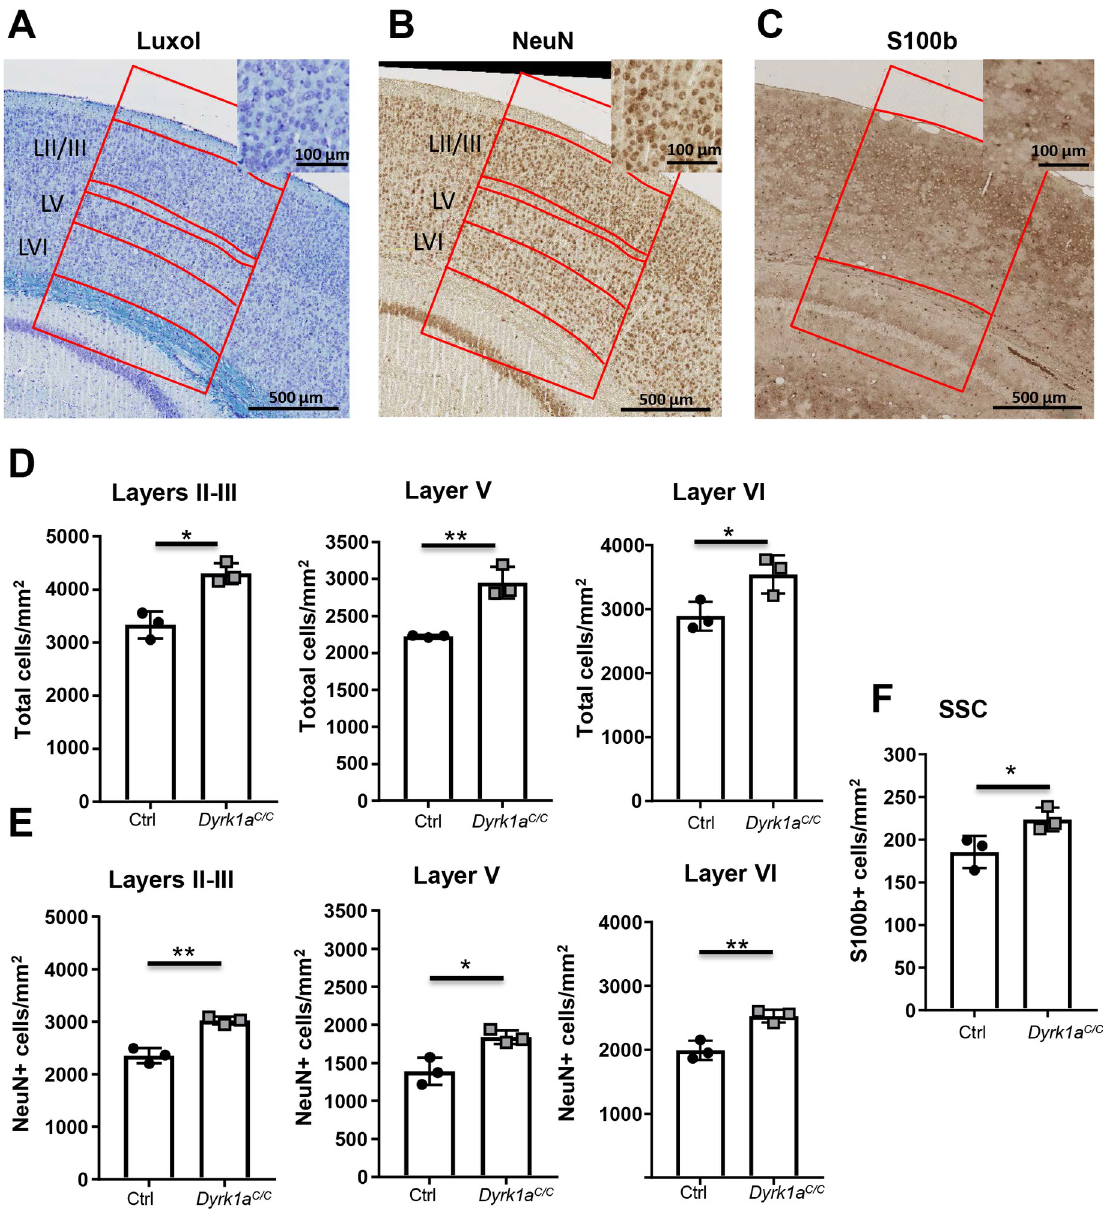
Fig 3. Analysis of cell density in the SSC of Dyrk1a C/C mice. Representative cresyl violet and luxol blue stained (A), NeuN-labeled (B) and S100b-labeled (C) coronal sections at Bregma -1.5 with the counting frames. (D-F) Relative density of cells counted within a frame of 0.1 cm width at the level of the SSC. Data are presented as point plots with mean ± SD with unpaired Student’s t-test, � p < 0.05, �� p < 0.01, ��� p < 0.001 (n = 3 females aged 3 months per